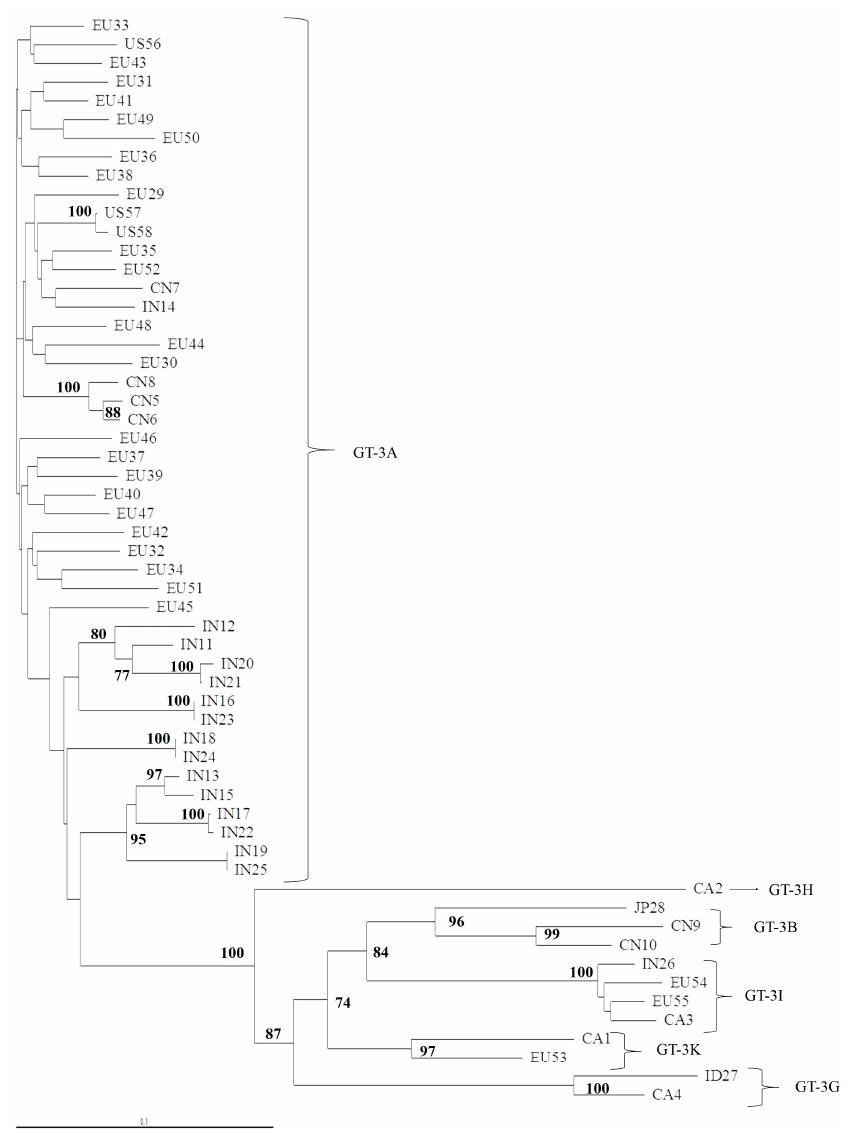
Figure 5. Phylogenetic tree of NS5A domain 1 of 58 complete genomes retrieved from the Los Alamos database. The maximum-likelihood phylogenetic rooted tree of NS5A domain 1 shows the relationships between different GT-3 subtypes of 58 isolates that had full genomes available. The geographic origin of each isolate is indicated with a code, followed by a progressive number. The geographic codes are: BR = Brazil, EU = Europe, US = USA, AU = Australia, CA = Canada, PK = Pakistan, IN = India, TH = Thailand, CN = China, ID = Indonesia, and JP = Japan. Evolutionary distances are indicated next to the branches.